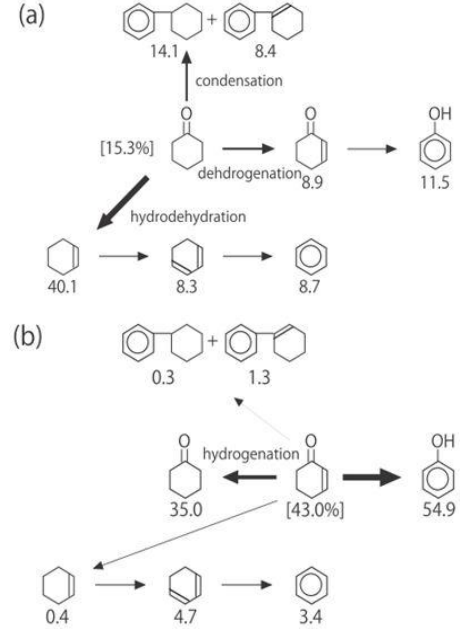
O) [(Mo Cl )Cl ]·6H O/SiO in a helium stream at 400 °C 3 2 6 8 6 2 2